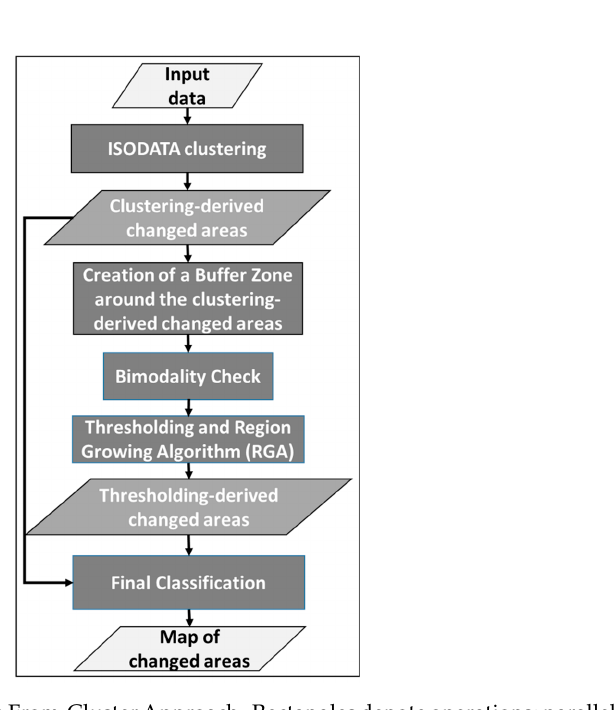
Figure1. FlowchartoftheBu ff er-From-ClusterApproach. Rectanglesdenoteoperations; parallelograms Figure 1. Flowchart of the Buffer-From-Cluster Approach. Rectangles denote operations; parallelograms denote data. denote